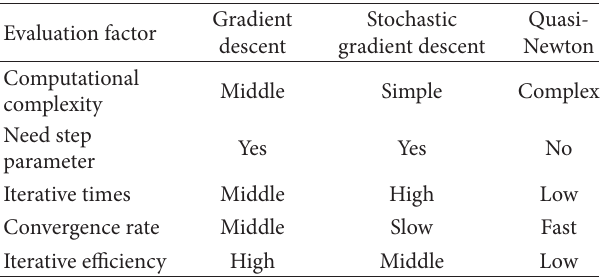
Table 2: Comparison of three optimization